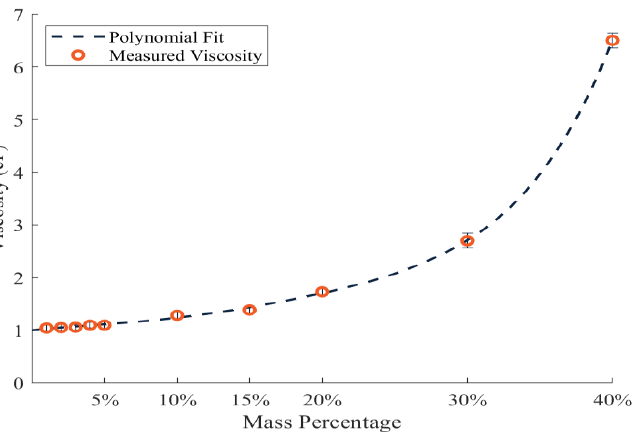
Figure 3. Viscosity of CaCl 2 Dihydrate (Data markers at lower mass percentages exceed the size of the error bars).